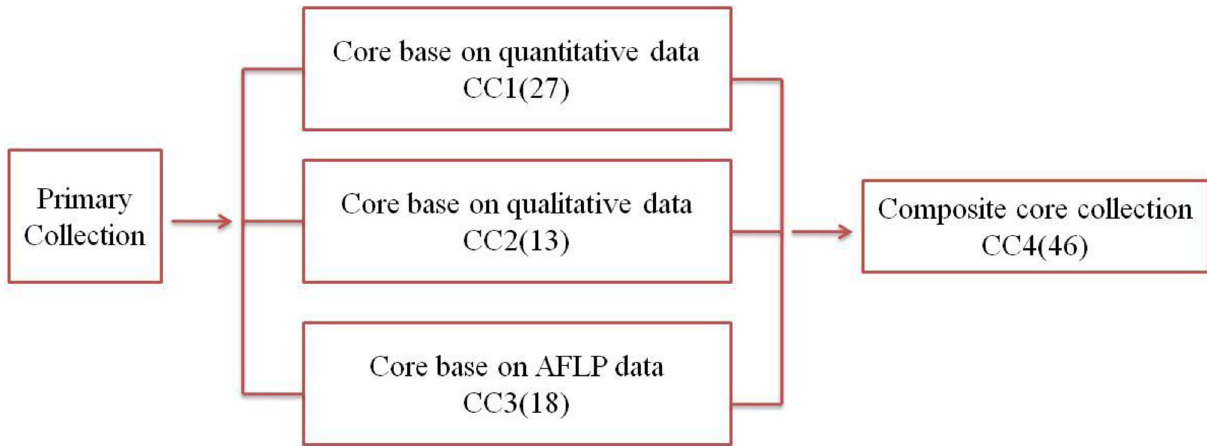
Fig 4. Flowchart describing the steps for development of a core collection for walnut. Numerical values indicate the number of accessions in respective cores.